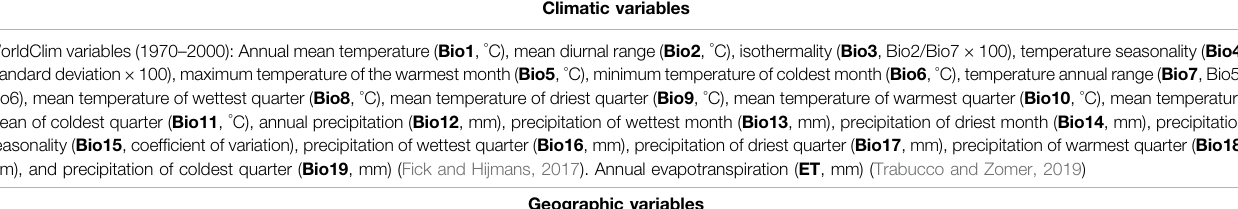
Climatic variables